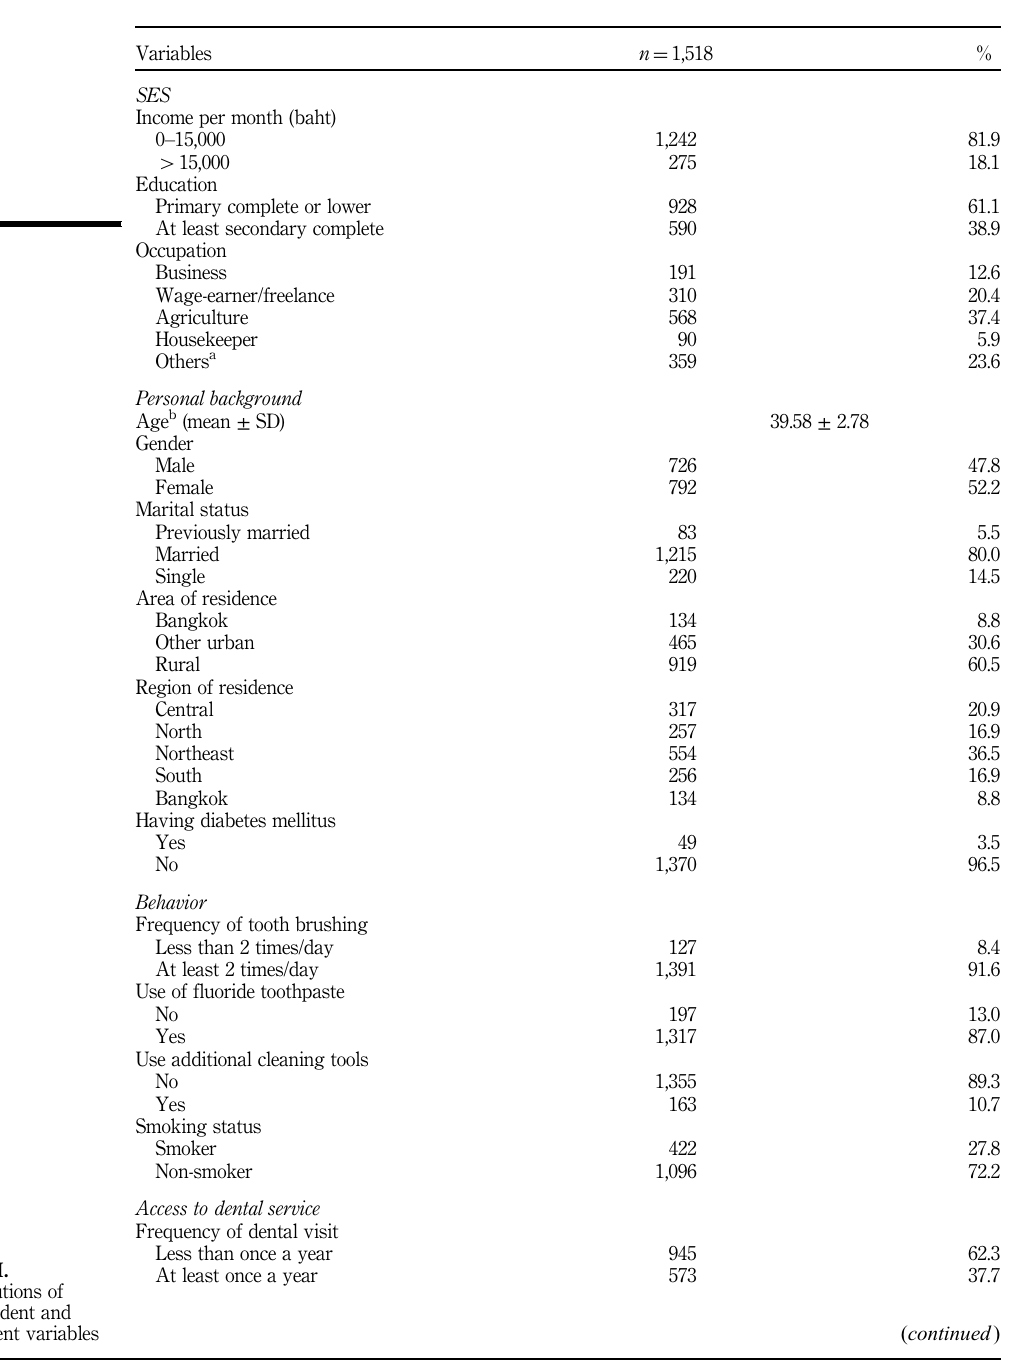
Table I. Distributions of independent and dependent